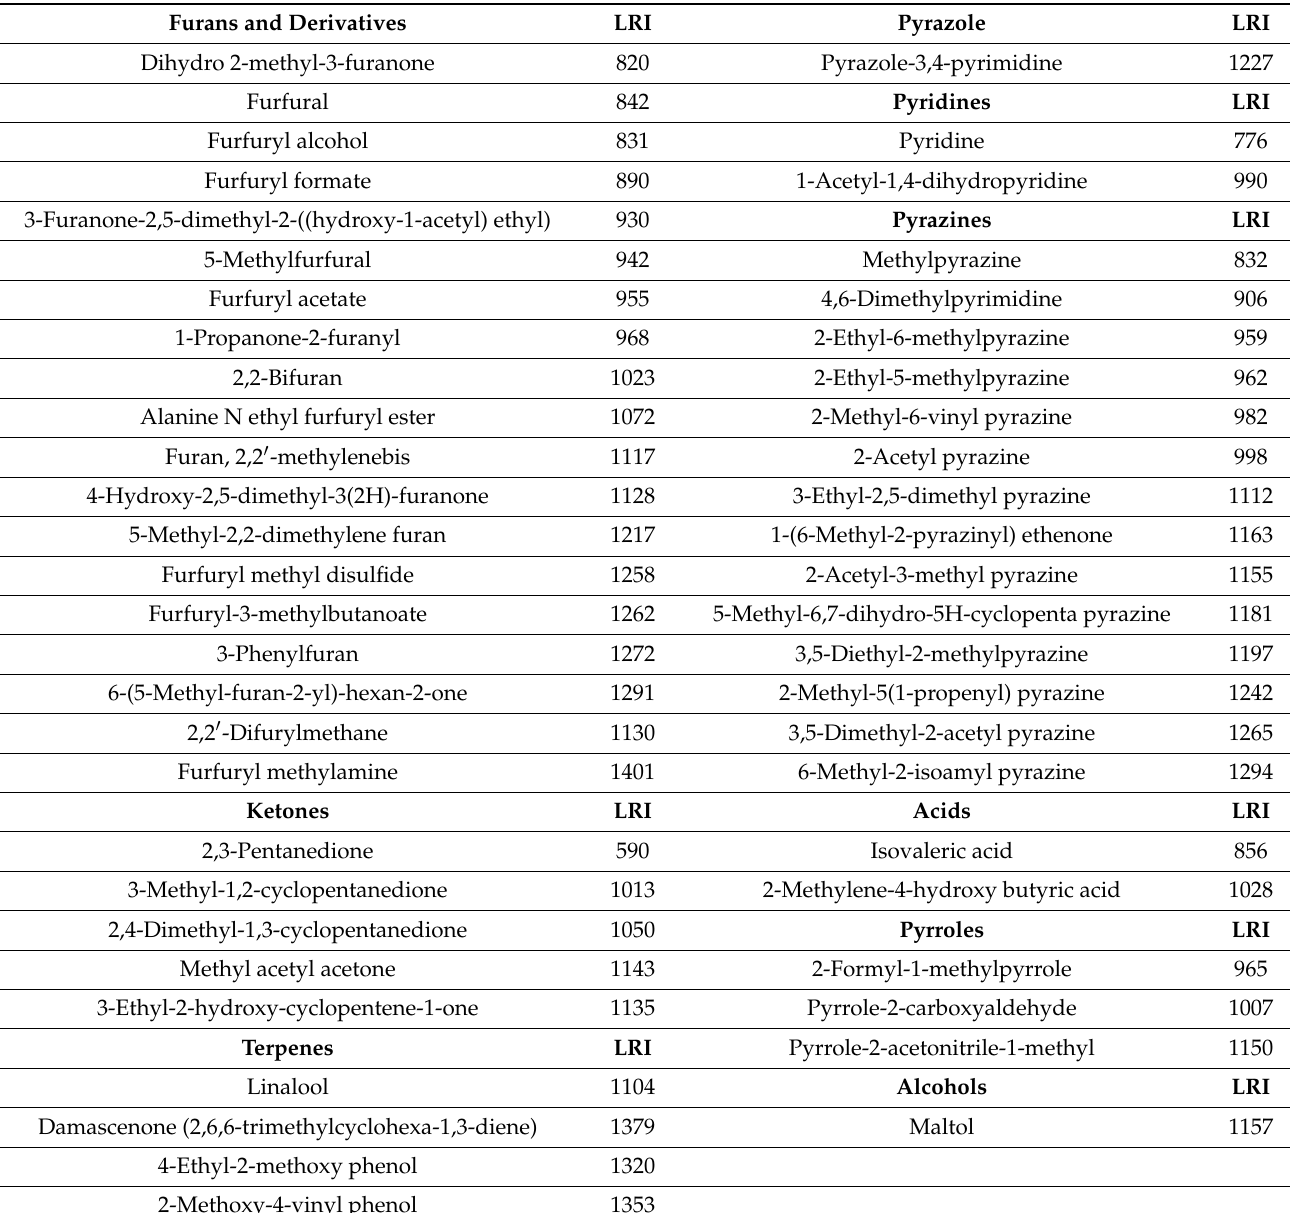
Table 2. List of compounds and related Linear Retention Index (LIR) detected in the roasted coffee headspace, listed by chemical